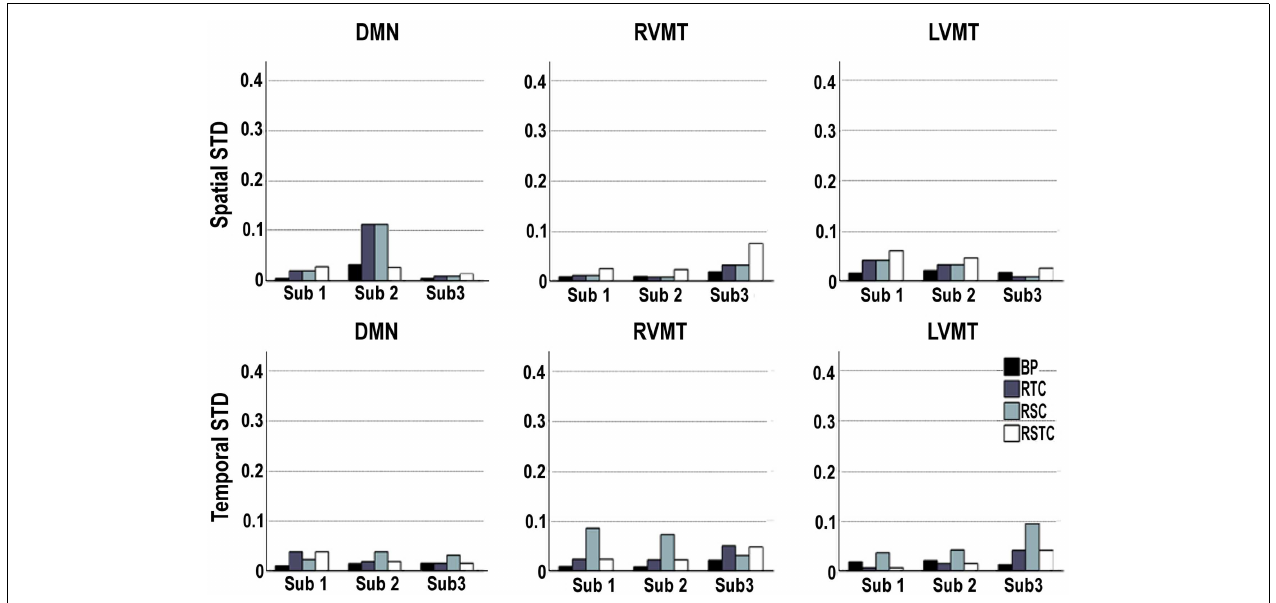
or DMN, right visual motor or RVMT, and left visual motor or LVMT), and for each ICA implementation (Back-projection or BP, temporally constrained orTC, spatially constrained or SC, spatio-temporal constrained or STC).The variability of the dynamic tracking performance results is expressed as the standard deviation across trials, per subject, brain network, and ICA